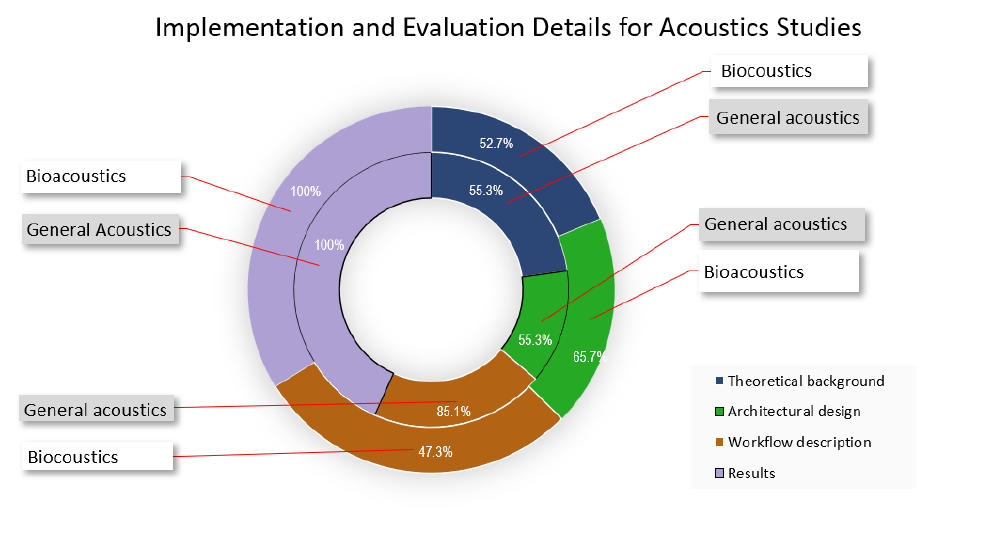
Figure 19. Implementation and evaluation details for acoustic studies.